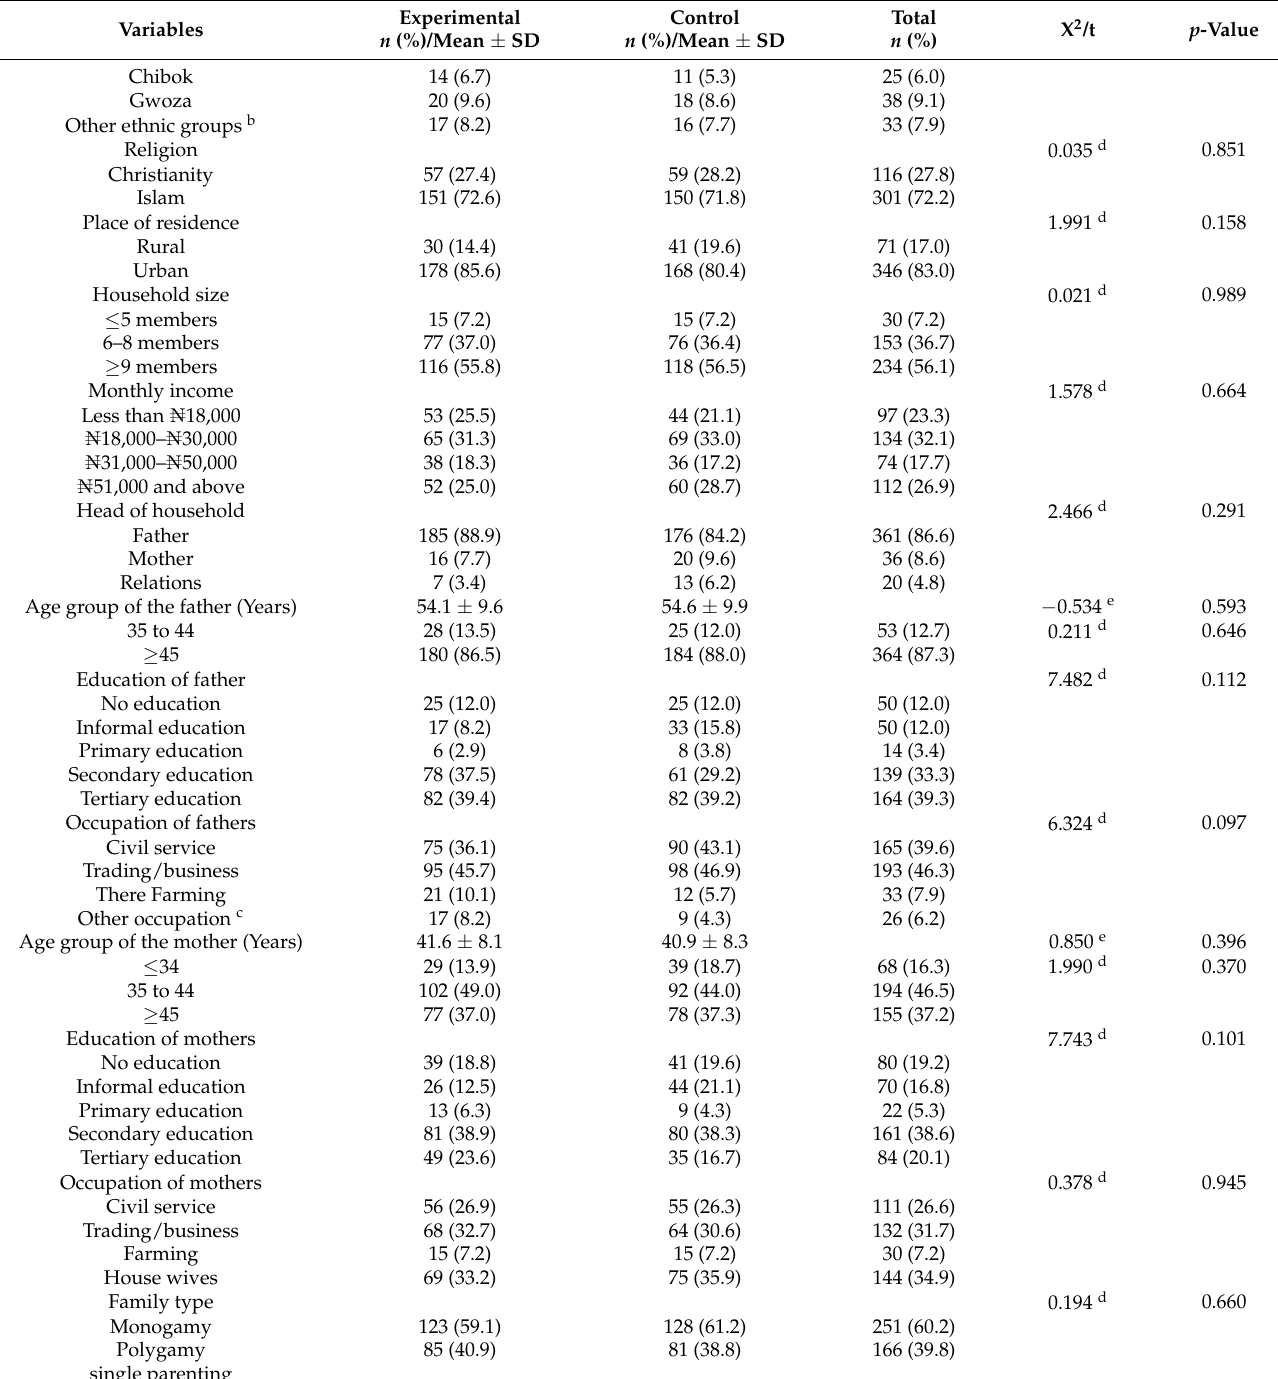
Table 3 indicates that the mean ± SD for knowledge score between experimental and control groups at baseline was 8.87 ± 4.3. The scores range from 0 to 19. There was no statistically significant difference between experimental and control group at baseline for knowledge ( p = 0.589). The mean ± SD for attitude score between experimental and